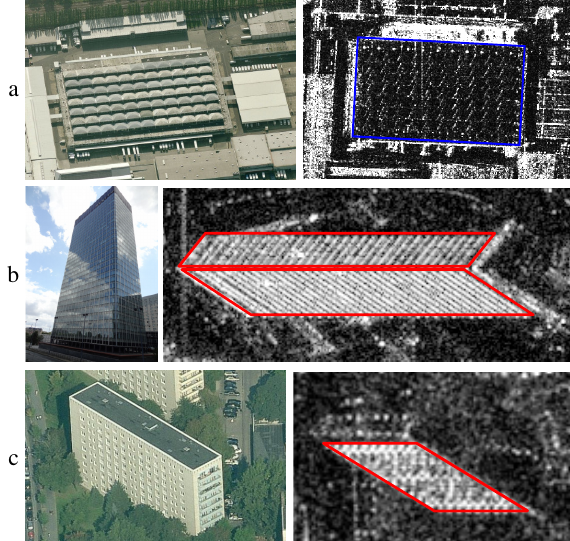
Figure 1: Typical building types in urban area: optical and intensity signature of an industrial hall (a, source: Bing ), the tower building Tour Initiale (b), and an apartment house in the Alexander Street, Berlin (c, source: Bing)